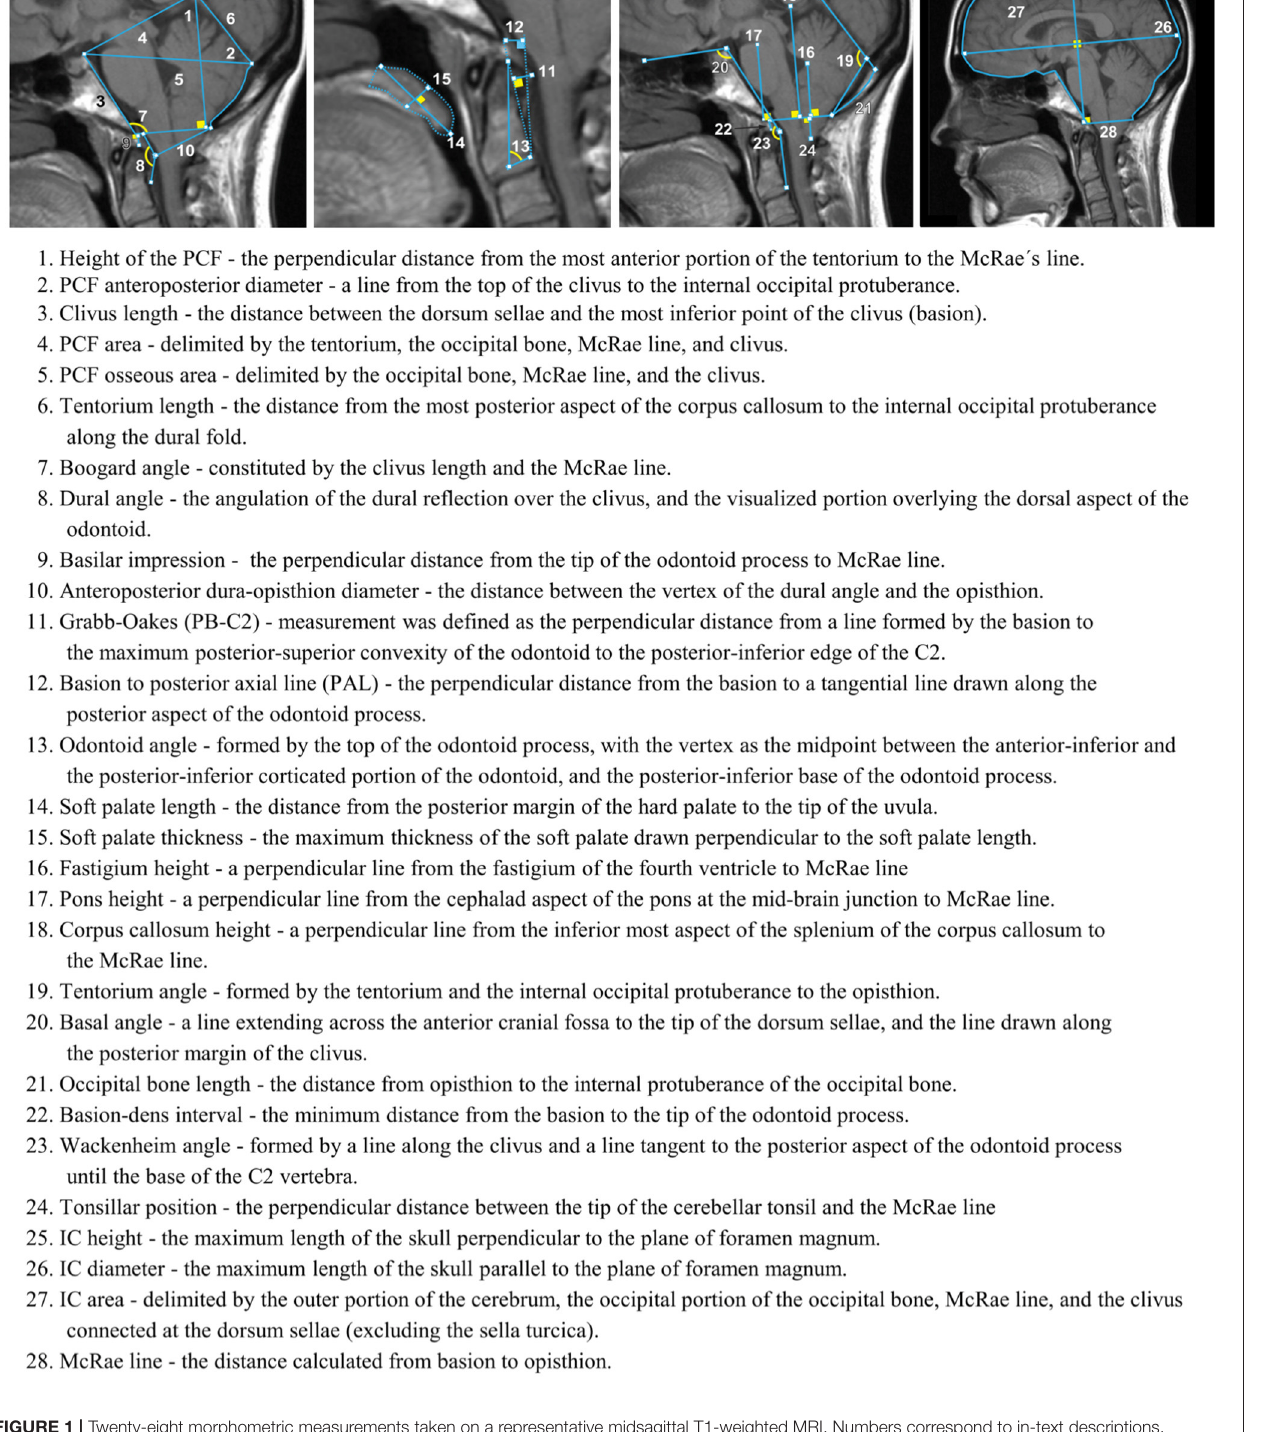
FIGURE 1 | Twenty-eight morphometric measurements taken on a representative midsagittal T1-weighted MRI. Numbers correspond to in-text descriptions.